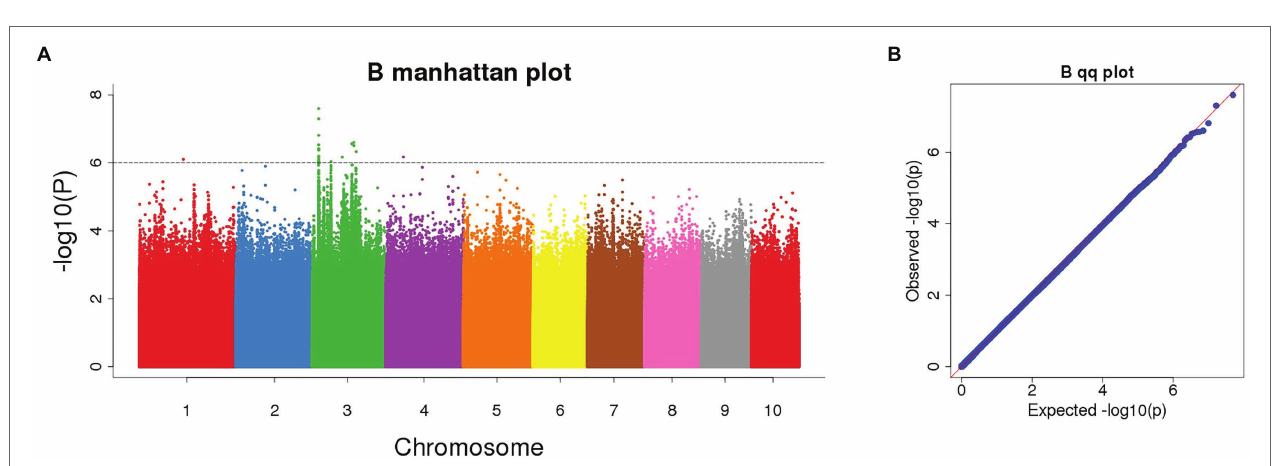
FIGURE 4 | (A) Manhattan plot of significant SNPs correlating with POD activity using the FarmCPU model; (B) Quantile-Quantile (Q-Q) plot.